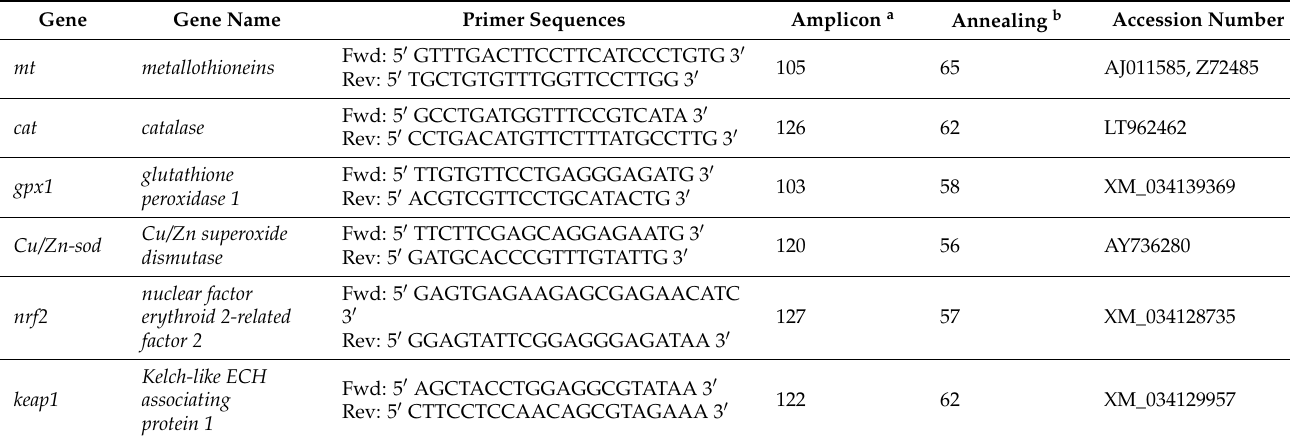
Table 1. Primer sequences, amplicon sizes, annealing temperatures and accession numbers for each target gene analyzed by qPCR in fish tissues. Fwd: forward primer; Rev: reverse primer; a : size in base pairs. b : temperature in ◦ C.